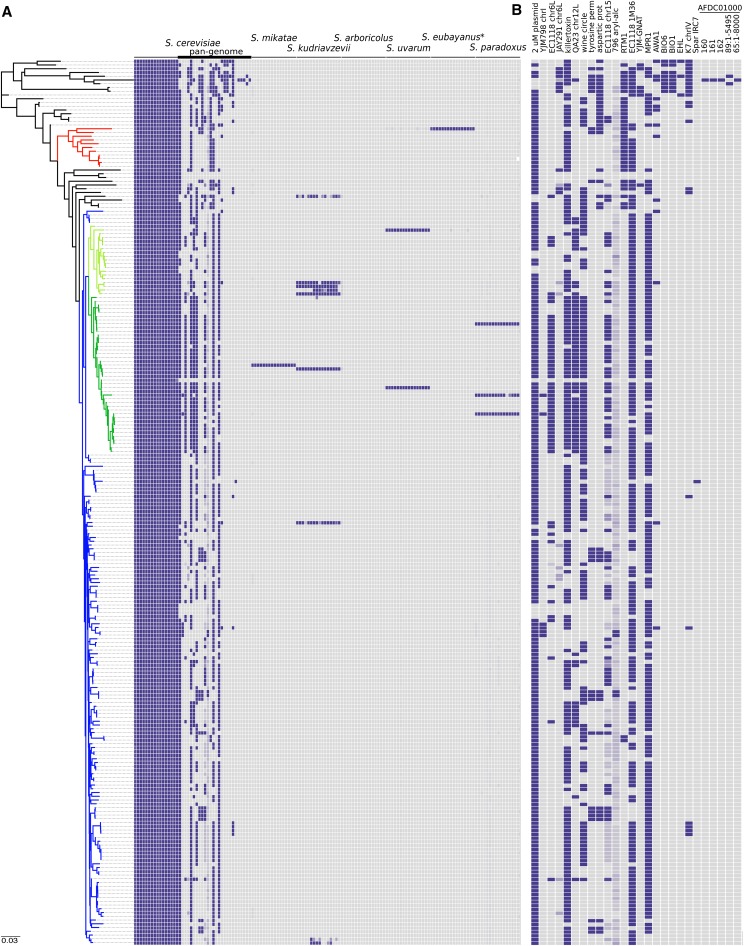
Genomic content differs across strains. (A) Sequence coverage was used to determine the genomic contribution of sequences from the Saccharomyces sensu stricto group in each strain. Each tile represents one of the 16 chromosomes of each species, except for the S. cerevisiae sequence set, which also contains 26 strain-variable accessory (pan-genome) loci. Strains are ordered according to the genome-wide SNP phylogeny, and colored as in Figure 1A. (B) A detailed display of the S. cerevisiae accessory elements of the pan-genome. Sequences of each locus can be found in File S1, and a high resolution figure, containing strain names is presented in Figure S2.